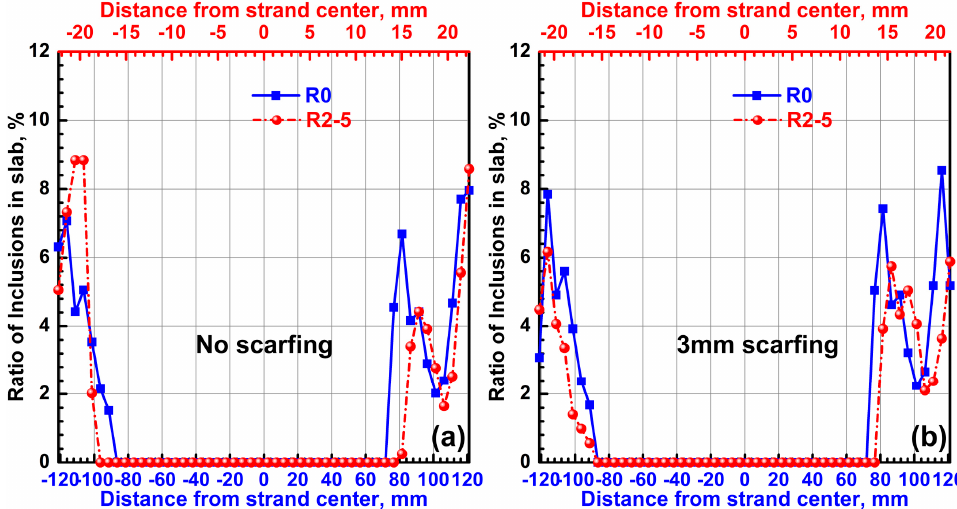
Figure 10. The inclusion distributions along the thickness direction before and after the R2-5 pass: the case without scarfing ( a ) and the case with 3 mm scarfing ( b ).